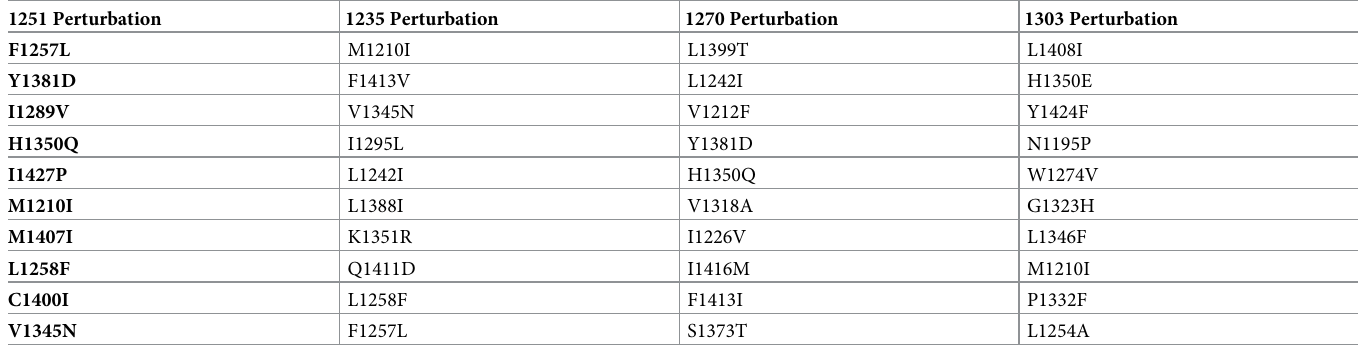
Table 2. Predicted stabilizing